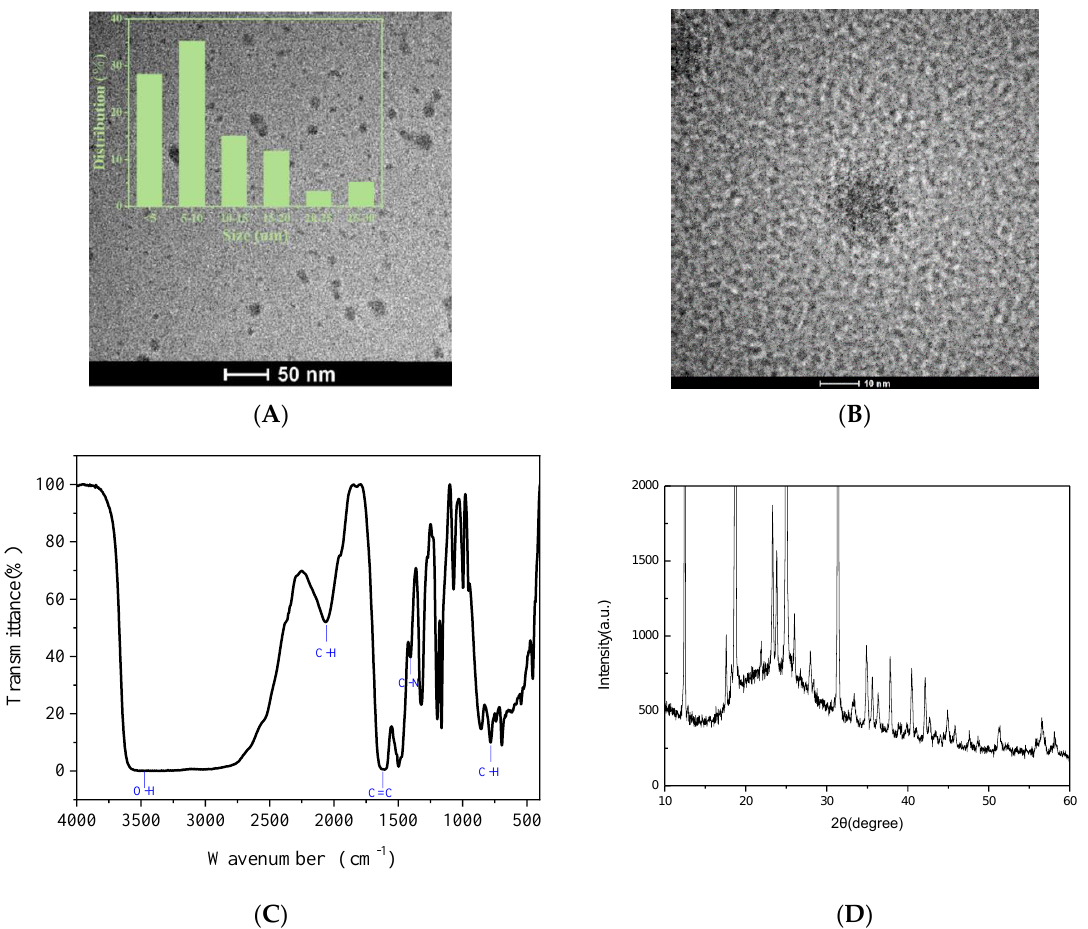
Figure 2. The analysis of N-CDs using ( A ) particle size distribution and ( B ) TEM images at different scales; ( C ) FT-IR; ( D ) XRD. scales; ( C ) FT-IR; ( D )